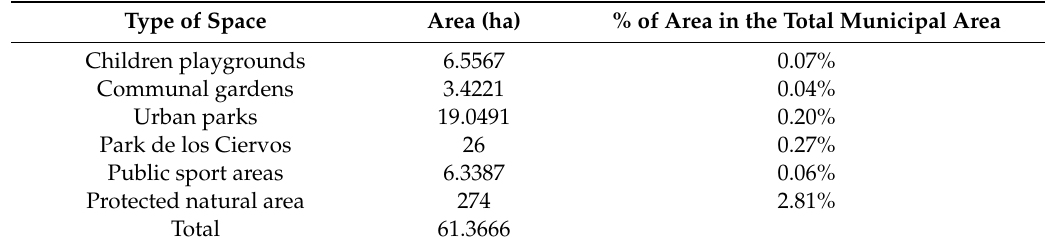
Table 2. Distribution of UPS area by type (Source: The Municipal development Plan PMDU 2015).